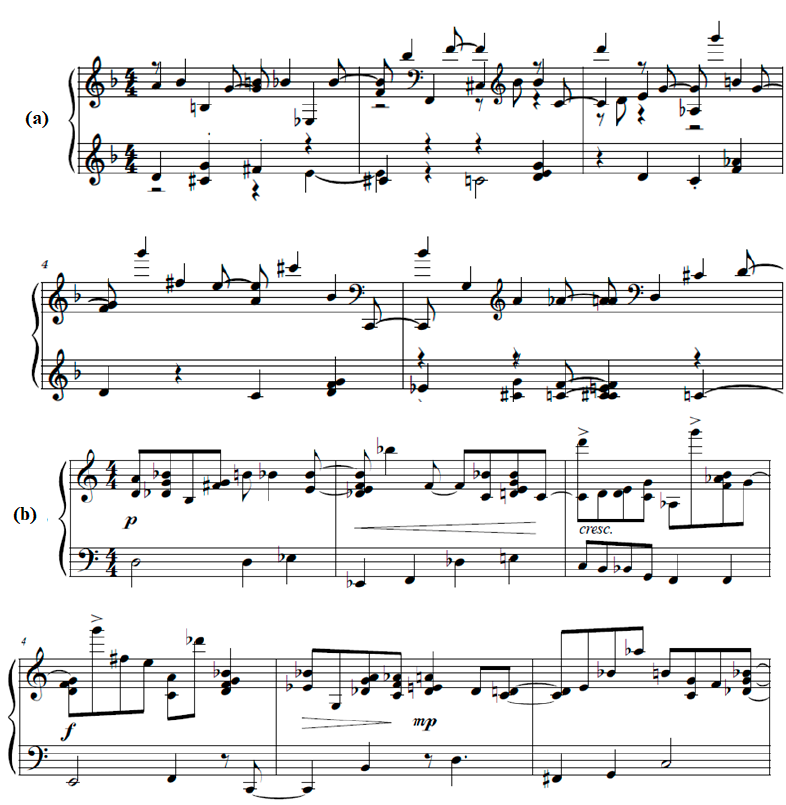
Figure 3. ( a ) Produced sample sound source; ( b ) edited sample sound source https://youtu.be/OQszeBCE7Xg (accessed on 7 August 2022).